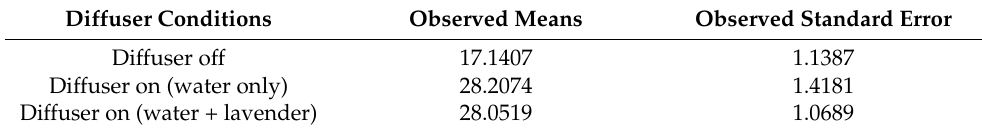
Table 4. Mean and standard error for each set of experimental conditions run on pecan pollen.